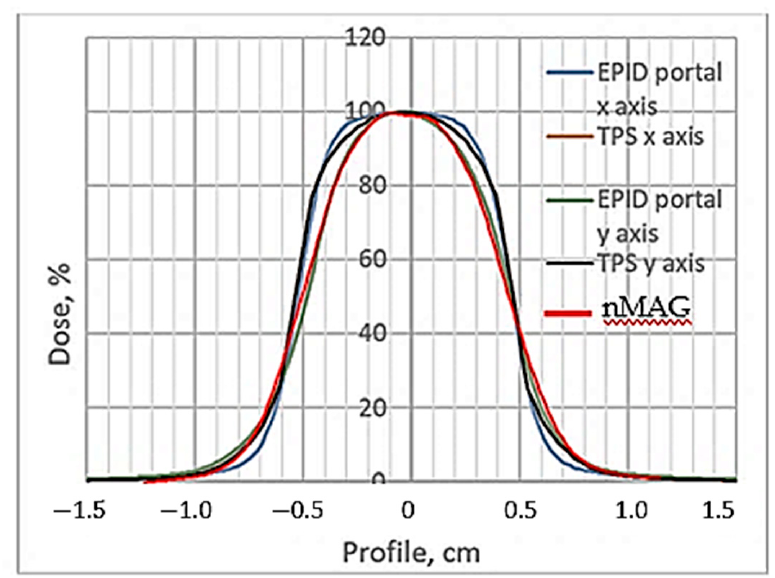
Figure 10. TPS, EPID and NMR evaluated dose profile of 12 Gy irradiated nMAG gel obtained 56 h post-irradiation. NMR evaluated gel’s dose profile is indicated in red. Table 2. Gamma evaluation results of experimentally (NMR evaluation) obtained dose profiles.